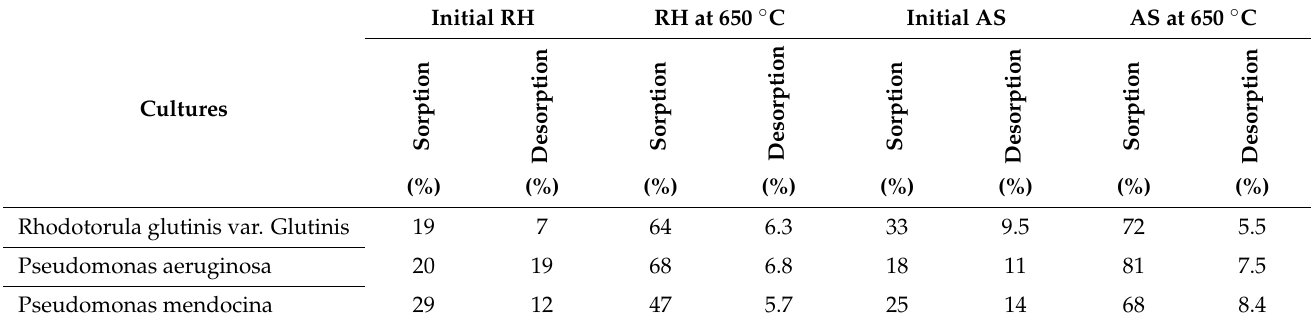
Table 3. Sorption and desorption of microbial cells from carbonized carriers. Reprinted with permis- sion from Ref. [50]. Copyright 2020, Jenny Stanford Publishing Pte.